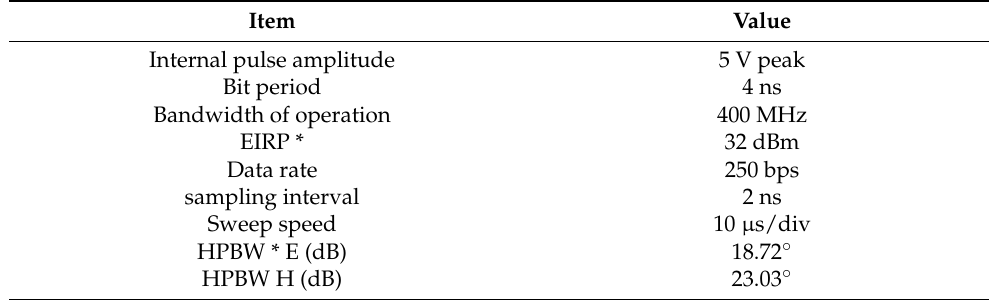
Figure 2. Channel sounder: ( a) Keysight’s DSO, ( b ) COST2201A evaluation board, ( c ) evaluation board antenna, ( d ) Altera FPGA board. Table 1. Channel Sounder